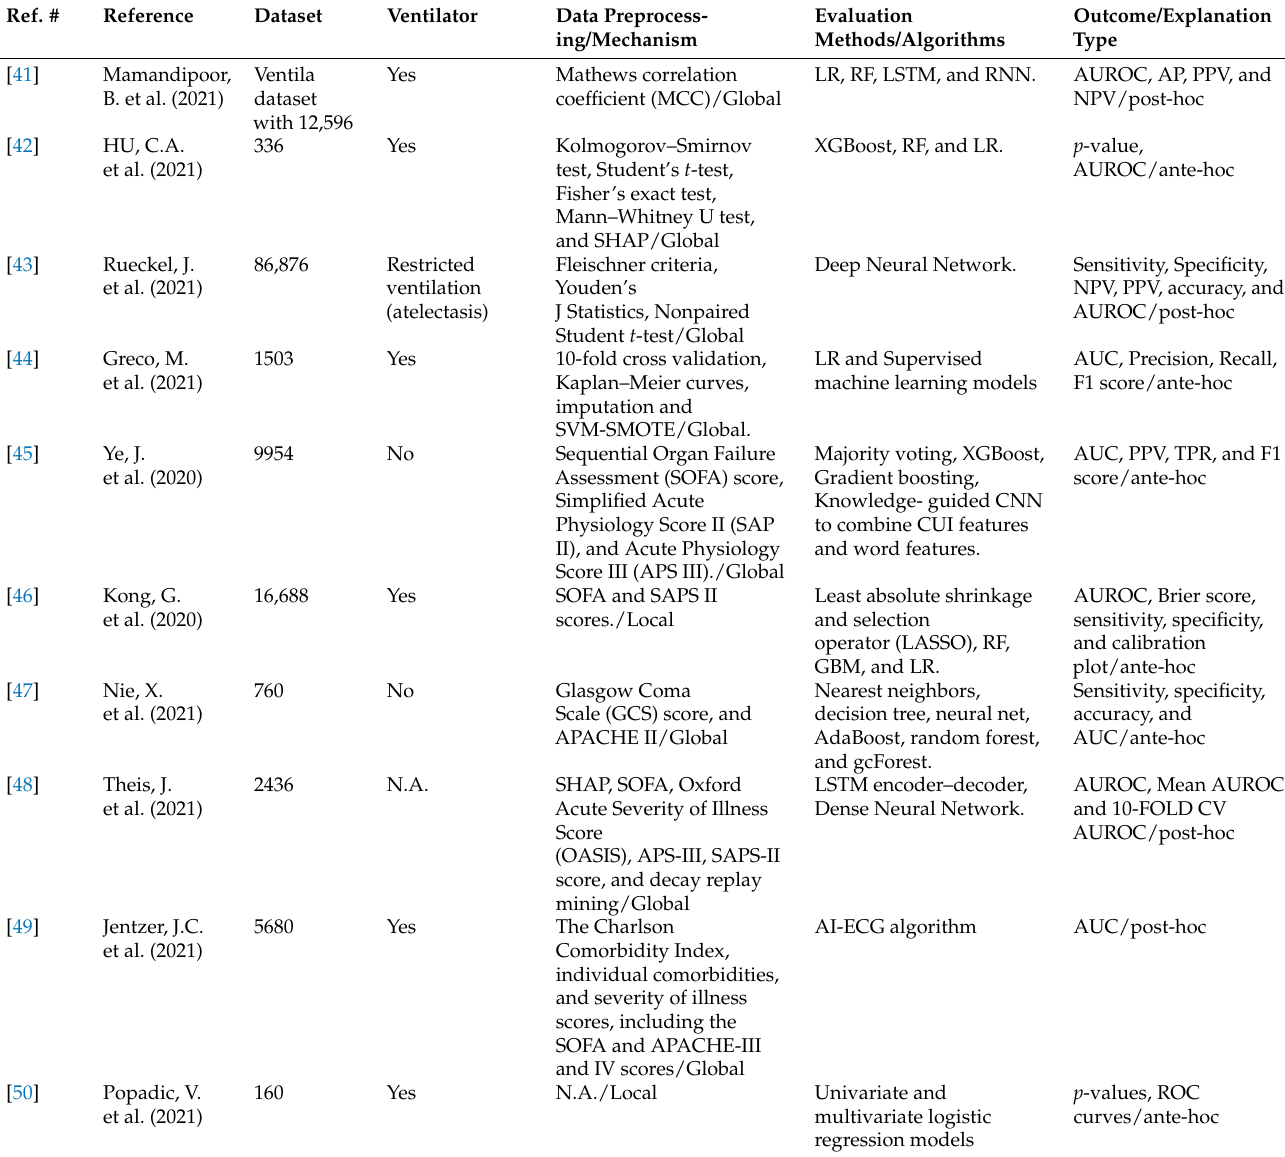
Table 4. Analysis for the hospital mortality prediction